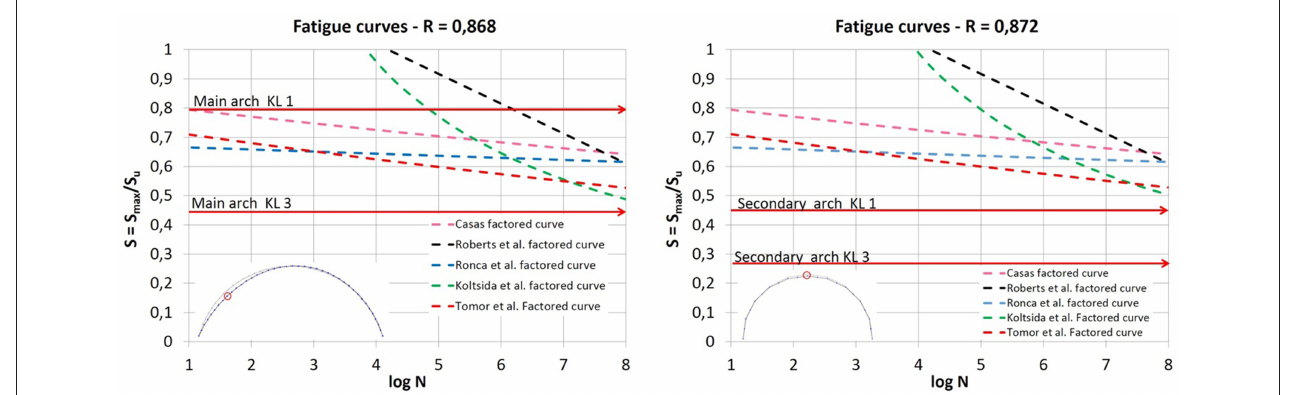
FIGURE 6 | Main arch (left) and secondary arch (right): calculation of the life cycles at the